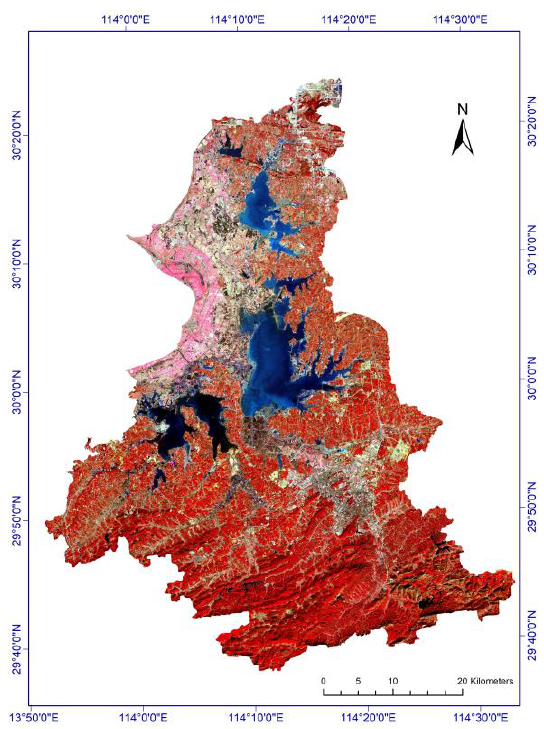
Figure 4. The study area of the Jinshui Basin and the input Sentinel-2 image. The false color image is composited with VNIR-red-green as RGB.